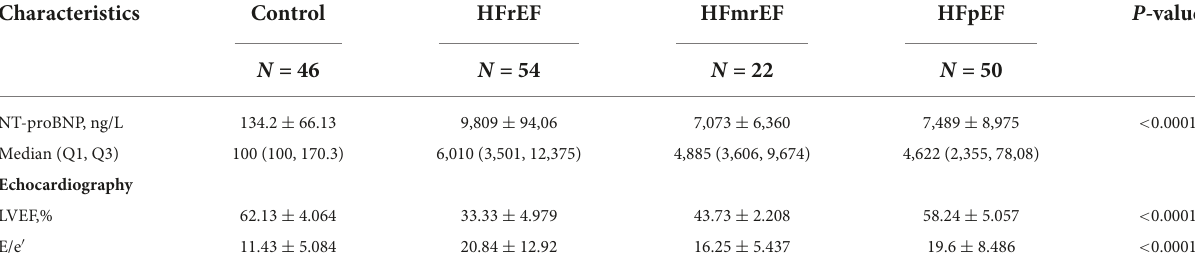
related to the identification of HF phenotypes. NT-proBNP